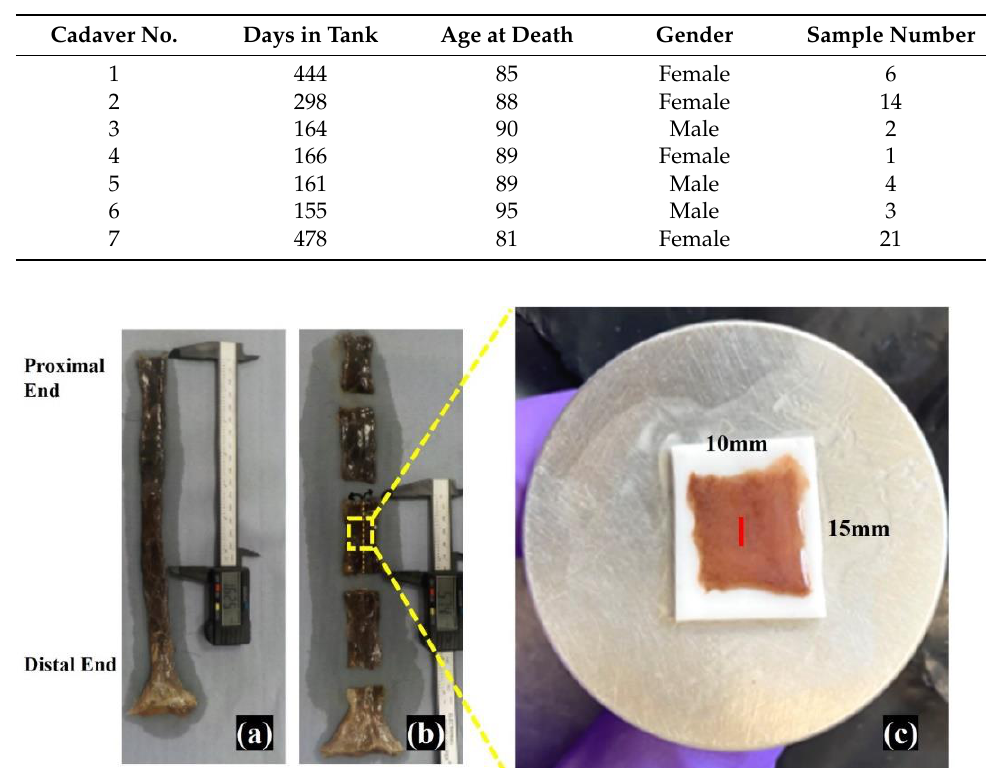
Table 1. Sample information, cadavers’ information and the number of samples obtained from each cadaver.